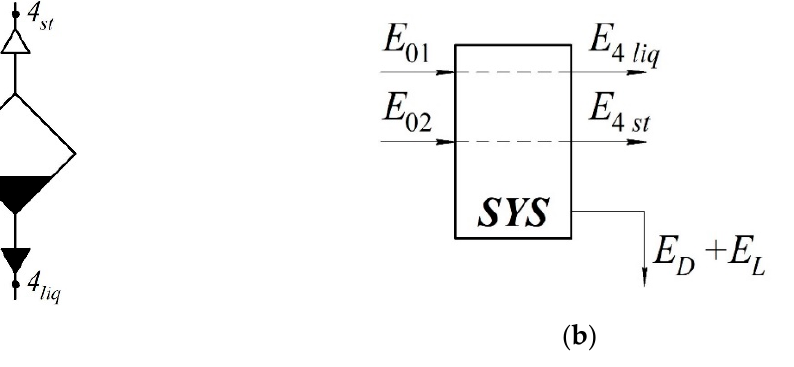
Figure 4. ( a ) “LVE + separator” system diagram and ( b ) scheme of exergy transformations: E D + E L — destruction and losses of exergy.